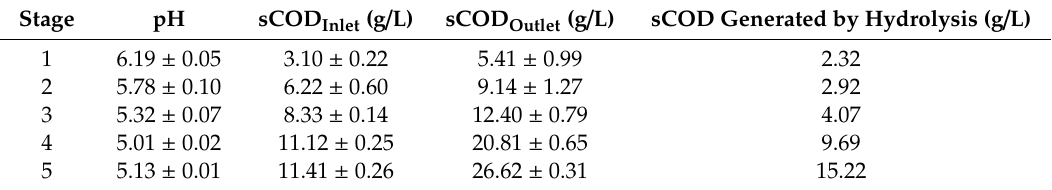
Table 6. Summary of monitoring results along ASHR